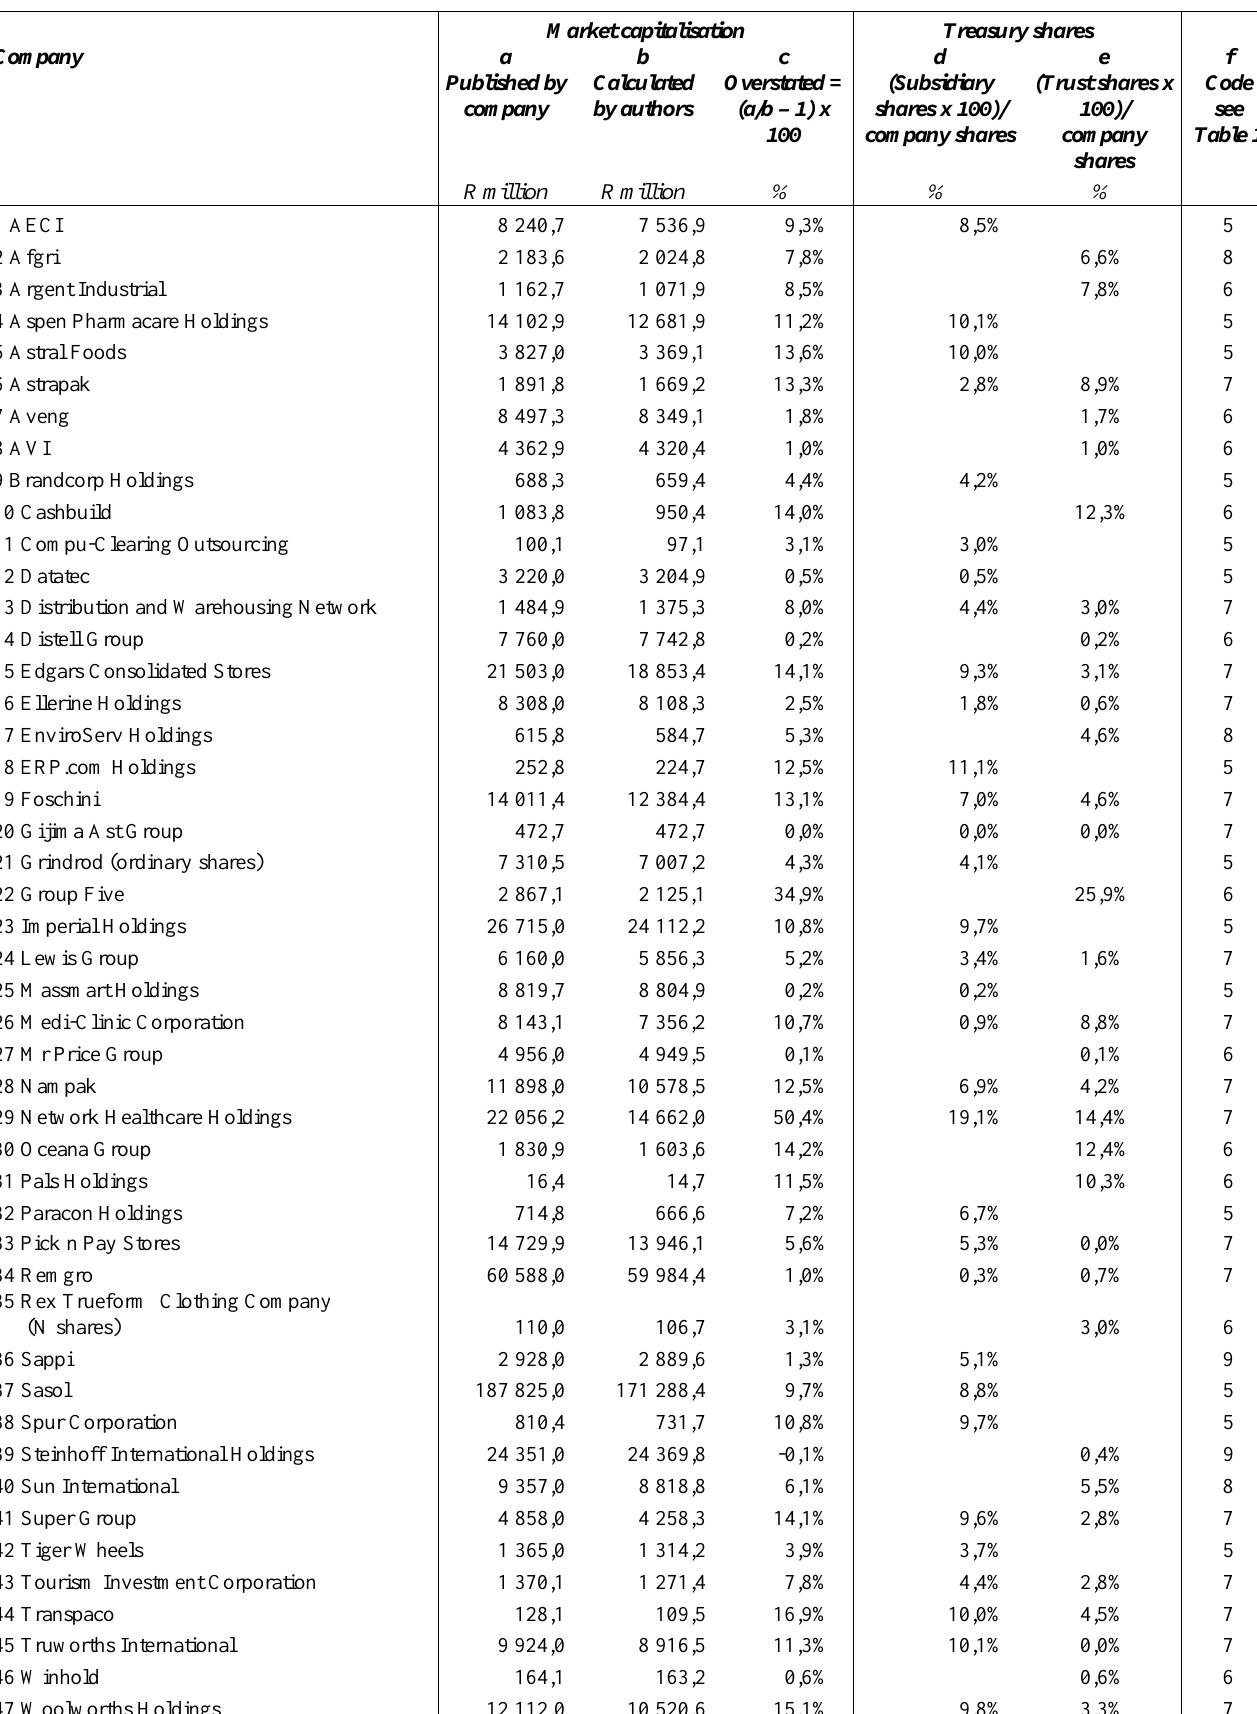
Table 3. Companies publishing market capitalisation not based on number of group shares in 2006 annual